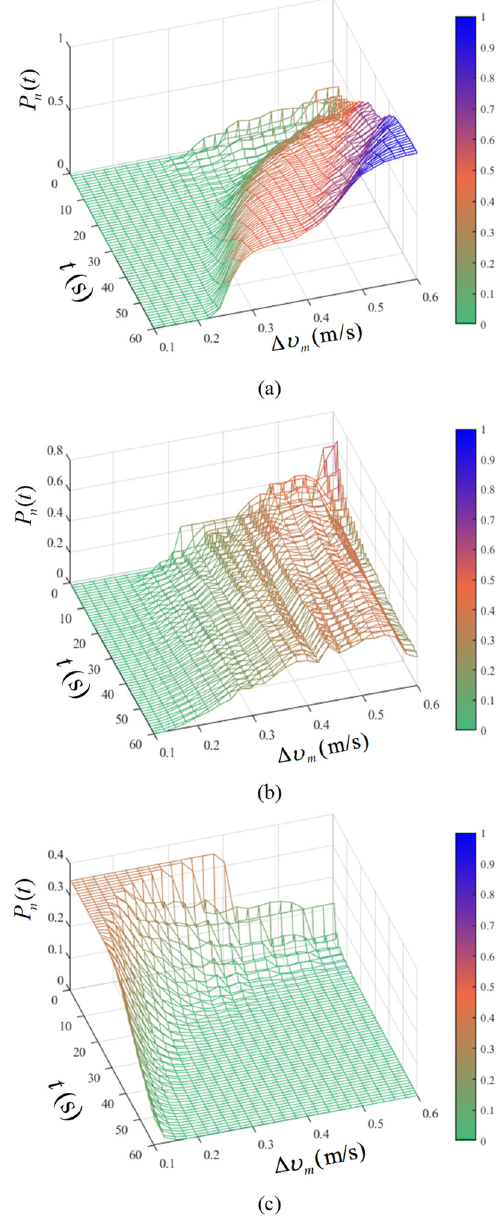
Figure 4. The trend of safety probability with safety sensitivity and time when a vehicle is first. ( a ) α = 0; ( b ) α = 0.5; ( c ) α =